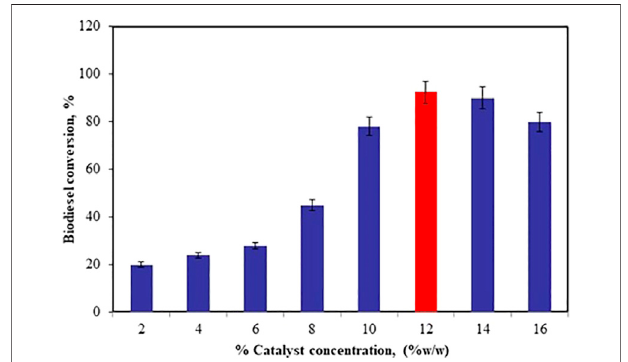
FIGURE 5 | Effect of catalyst concentration on biodiesel production.